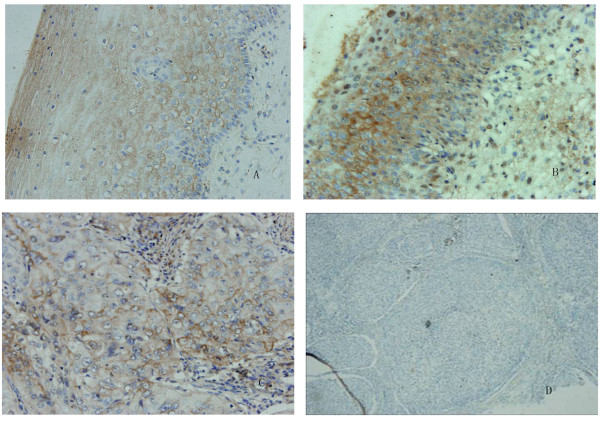
Immunohistochemical detection of IGFBP-5 and cFLIP in patient tissues. A, Expression of IGFBP-5 in CIN I tissue: ++(×400); B, Expression of IGFBP-5 in CIN II tissue: +++ (×400); C, Expression of cFLIP in cervical cancer tissue: ++ (×400). D, Expression of IGFBP-5 in cervical cancer tissue: - (×200).